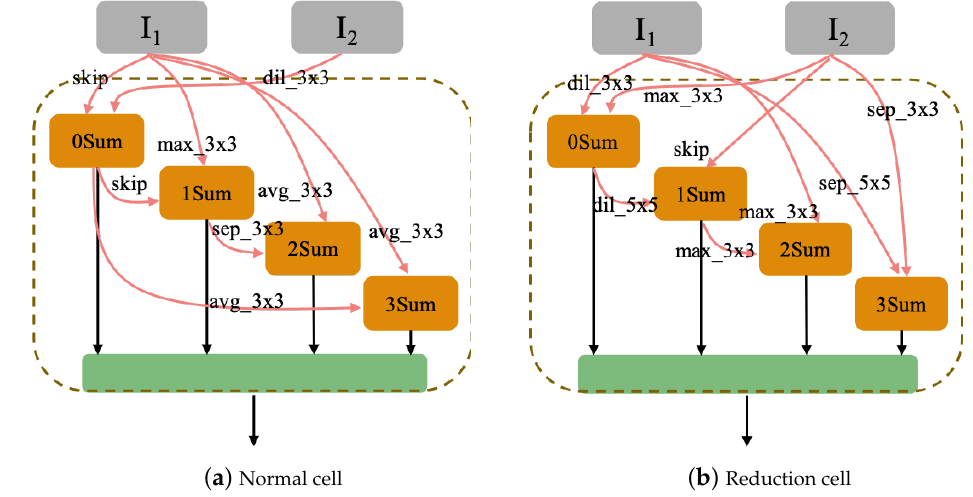
Figure 11. Optimal architecture of CPSO-Net for the biased Salinas